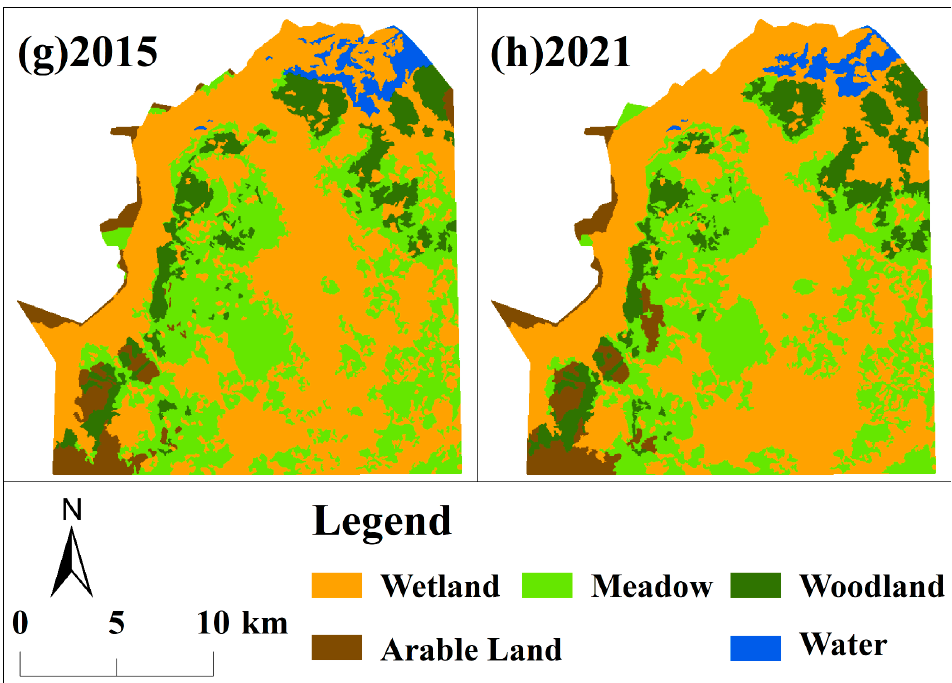
Figure 3. Five-year by five-year landscape spatial distribution map in the HNNR from 1985 to 2021, where ( a – h ) are the spatial distribution of the landscape in 1985, 1990, 1995, 2000, 2005, 2010, 2015 and 2021, respectively.